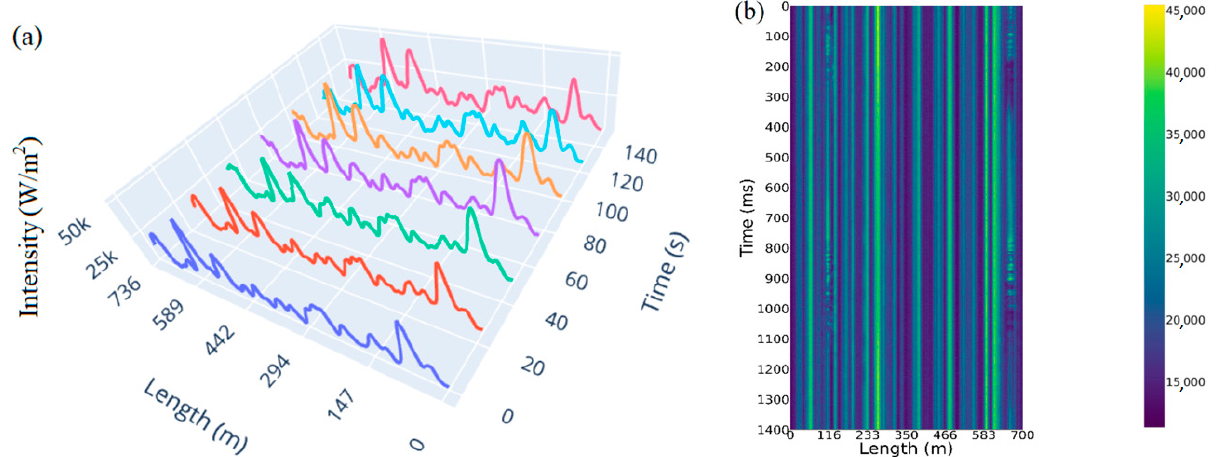
Figure 1. ( a ) Three-dimensional representation of a set of signal traces; and ( b ) an image of the space–time diagram, using a color map.